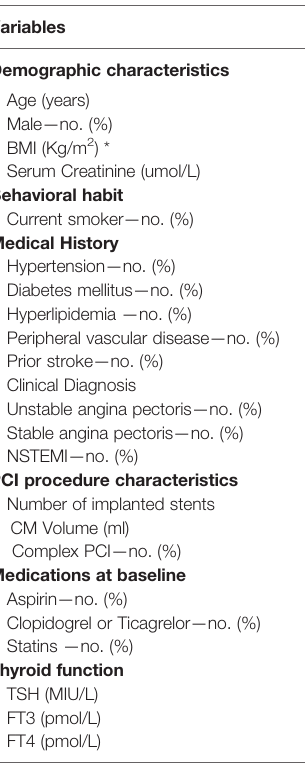
TABLE 1 | Characteristics of the patients at baseline.